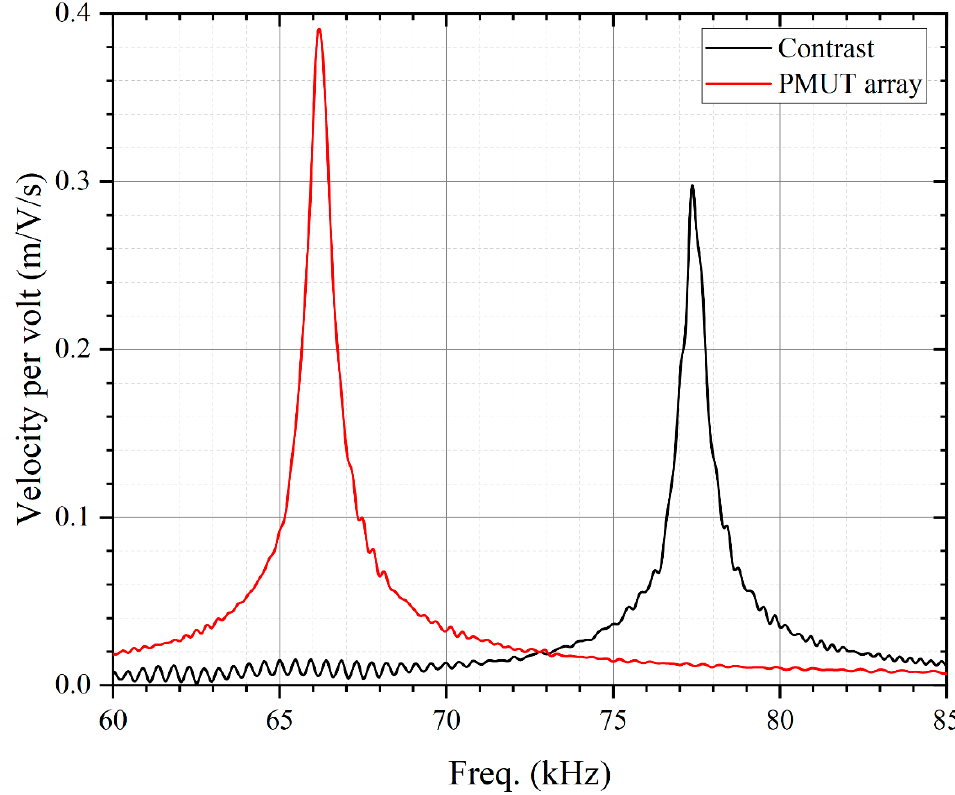
Figure 5. PMUT mechanical characterization: Frequency domain velocity per volt characterization of the PMUT with LDV. The result shows that the velocity of the designed PMUT ( red ) is 30% higher than that of the contrast PMUT ( black ), indicating that the designed PMUT has higher transmit sensitivity and can produce higher output sound pressure.